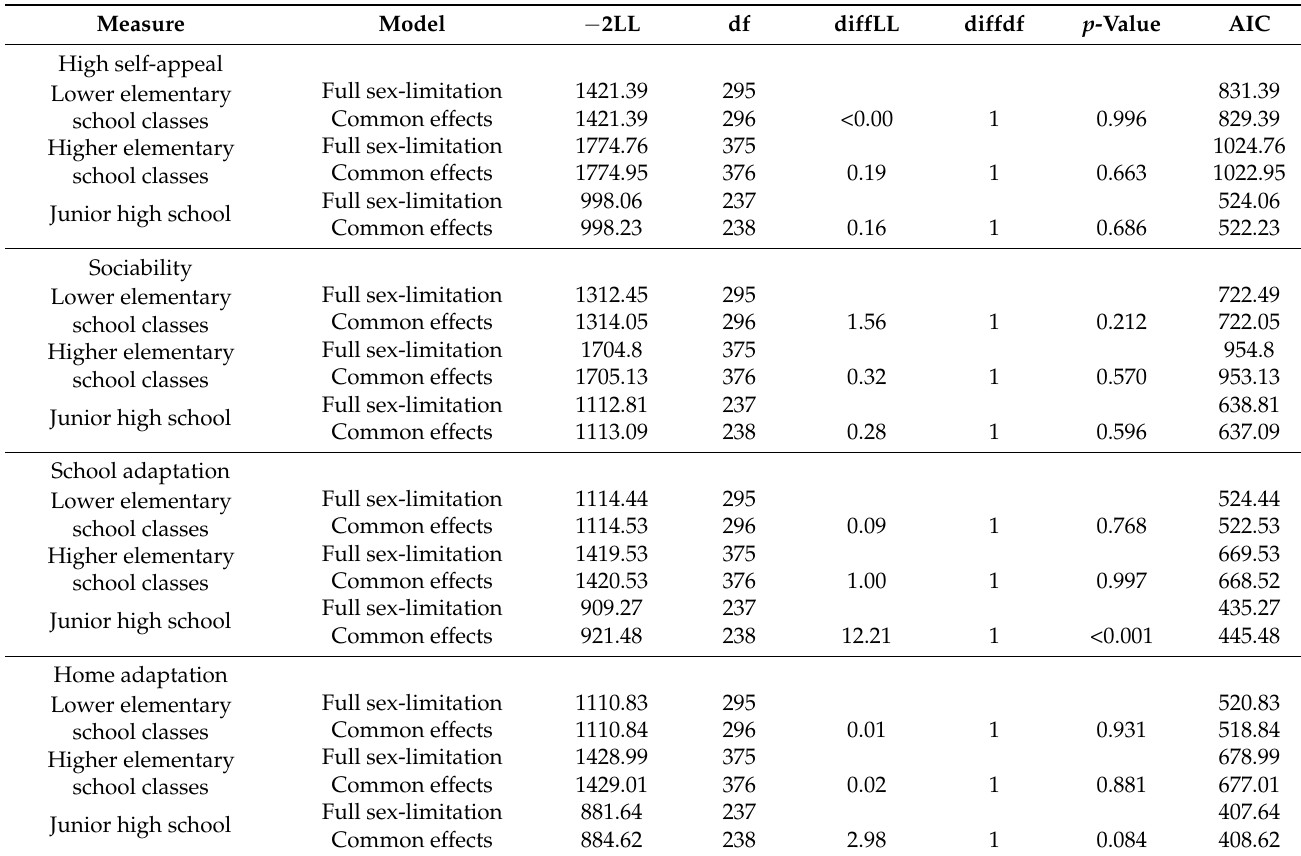
Table 4. Comparison of full sex-limitation models and common effects models to consider qualitative sex